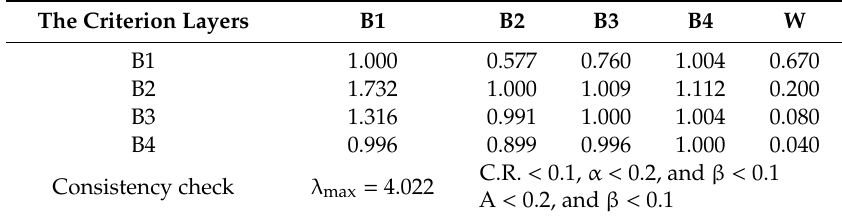
Table A2. The fuzzy judgment matrix of criterion layers.